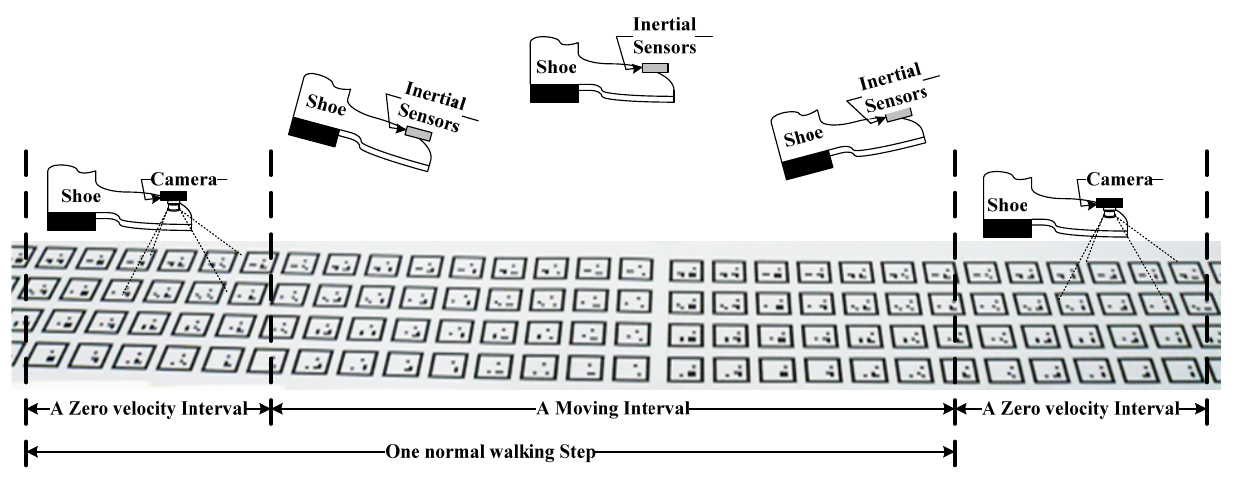
Figure 4. A Zero velocity interval and a moving interval of a walking